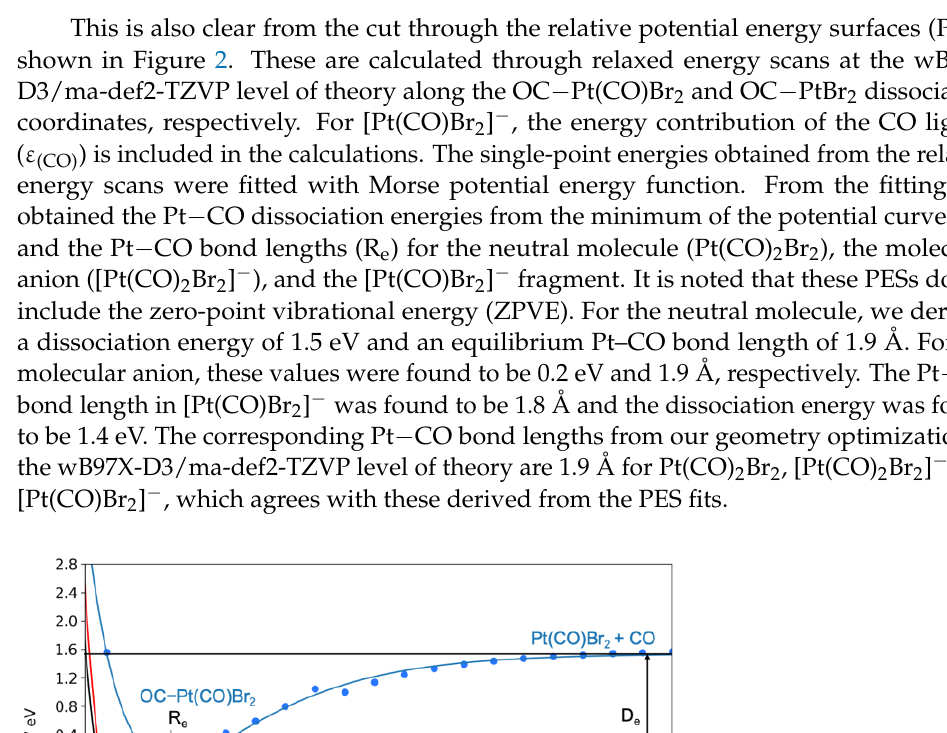
Figure 1. Negative ion yields for the loss of one and two CO ligands. Top : loss of one CO ligand; bottom : loss of two CO ligands.